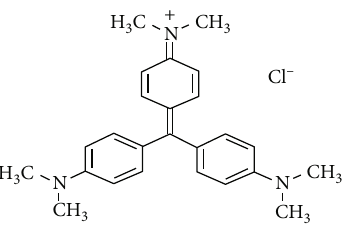
Figure 1: Chemical structure of crystal